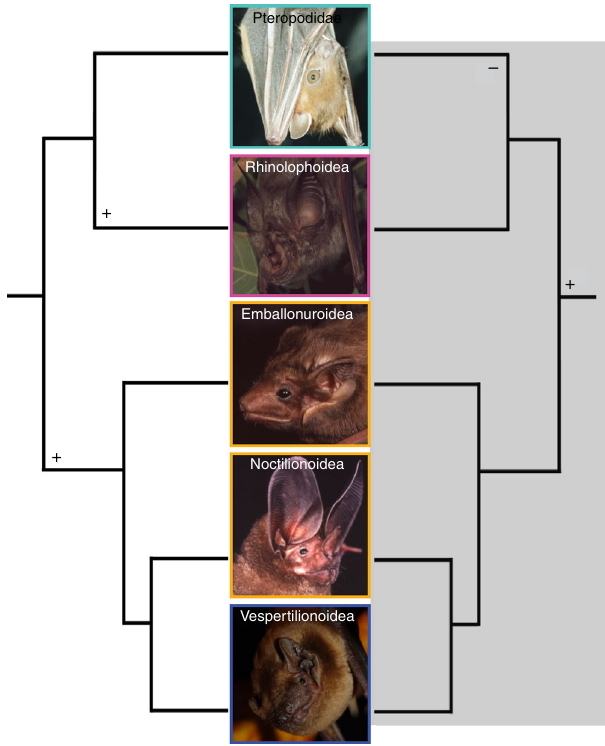
Fig. 1 Two equally parsimonious hypotheses for the origination of laryngeal echolocation in bats. The unshaded side depicts the two origins hypothesis and predicts that laryngeal echolocation originated in the common ancestor to the Emballonuroidea, Noctilionoidea, and Vespertilionoidea and again in the Rhinolophoidea. The shaded side depicts the single origin hypothesis, which predicts laryngeal echolocation was present in the common ancestor of all bats and lost in the Pteropodidae. Middle column displays (top to bottom) fi ve 30 – 35 g species from each of these major groups: Cynopterus brachyotis (non-echolocating, phytophagous), Rhinolophus hildebrandti (echolocating, predatory), Taphozous melanopogon (echolocating, predatory), Tonatia evotis (echolocating, predatory), Nyctalus noctula (echolocating, predatory). Please note that bats with constant frequency (CF), multi-harmonic frequency-modulated calls (MH) and fundamental harmonic frequency modulated calls (DH) (i.e., most energy in fundamental harmonic) are found in both suborders of bats. Photographs by Brock Fenton and Signe